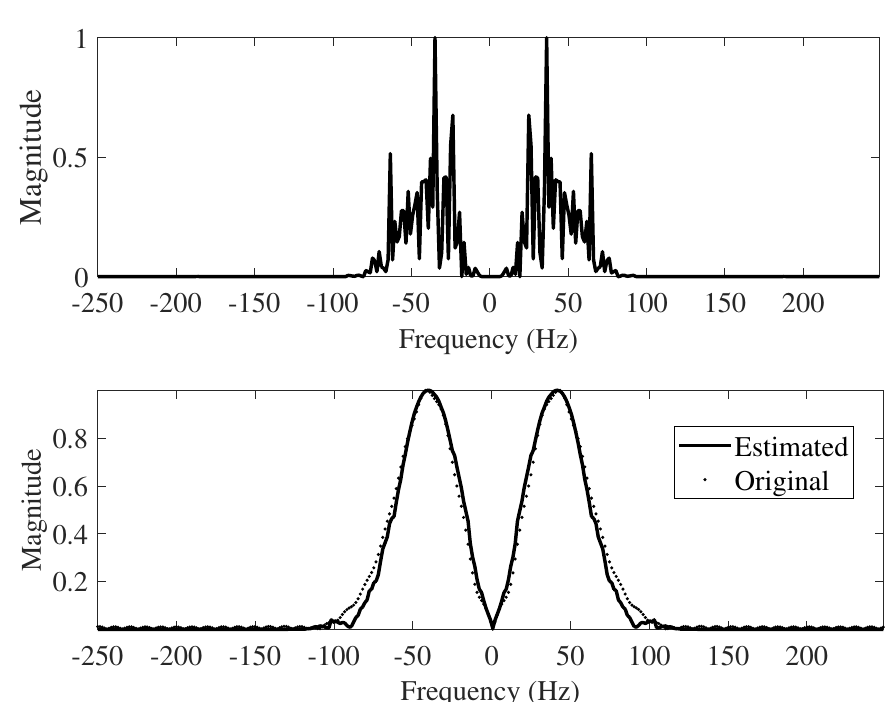
Figure 6. Frequency-domain views of the wavelet recovery process (Q = 0.8 Y). Top: frequency- domain first iteration; Bottom: frequency-domain final iteration.